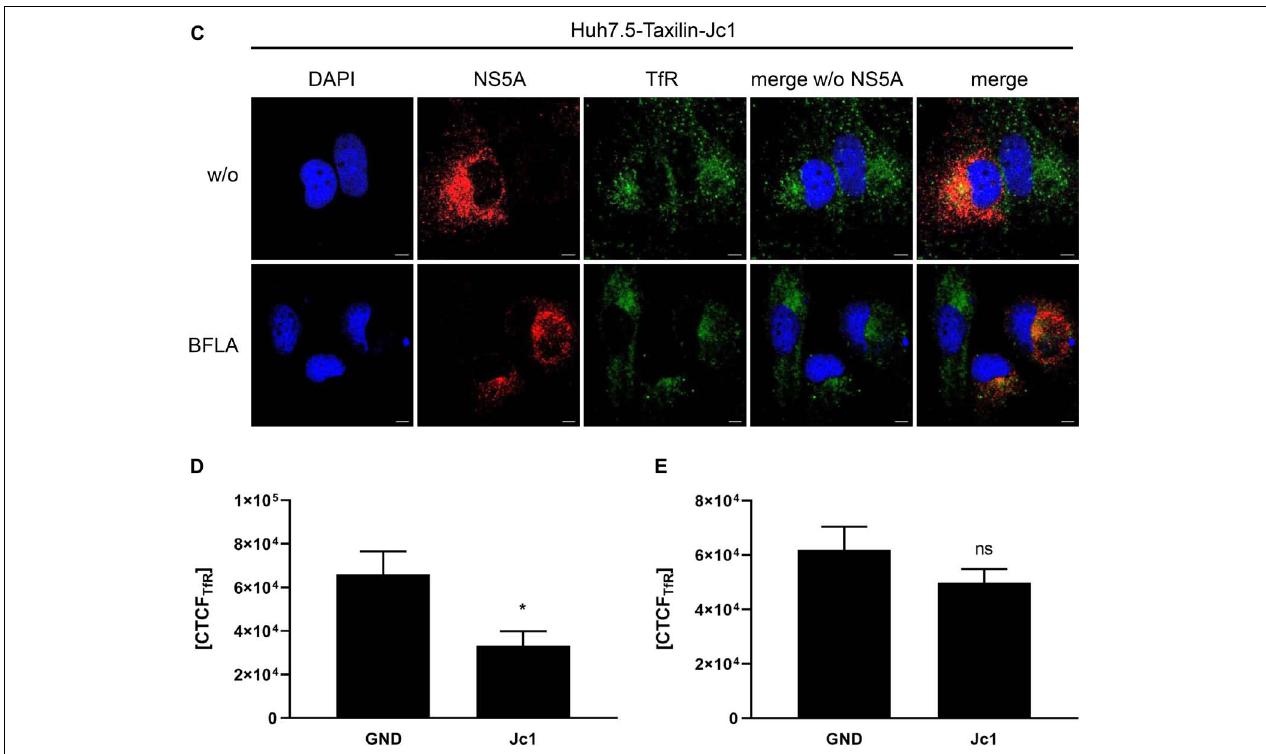
FIGURE 3 | Bafilomycin A leads to an accumulation of TfR in HCV-replicating cells. (A) CLSM analysis of HCV-negative Huh7.5 cells (GND) treated with BFLA (50 nM) for 16 h. The cells were stained with TfR (green) and NS5A-specific (red) antibodies. Nuclei were stained with DAPI (blue). Laser intensity and digital gain were kept constant for untreated and BFLA-treated cells. Magnifications, x100. Scale bar represents 5 µ m. (B) CLSM analysis of HCV-positive Huh7.5 cells (Jc1) treated with BFLA (50 nM) for 16 h. The cells were stained with TfR (green) and NS5A-specific (red) antibodies. Nuclei were stained with DAPI (blue). Laser intensity and digital gain were kept constant for untreated and BFLA-treated cells. Magnifications, x100. Scale bar represents 5 µ m. (C) CLSM analysis of HCV-positive Huh7.5-Taxilin cells (Jc1) treated with BFLA (50 nM) for 16 h. The cells were stained with TfR (green) and NS5A-specific (red) antibodies. Nuclei were stained with DAPI (blue). Laser intensity and digital gain were kept constant for untreated and BFLA-treated cells. Magnifications, x100. Scale bar represents 5 µ m. (D) Quantification of the fluorescence intensity of TfR in HCV-positive (Jc1) and HCV-negative (GND) Huh7.5 cells. Total fluorescence per cell was calculated using ImageJ software and the following formula: corrected total cell fluorescence (CTCF) = integrated density - (area of selected cell × mean fluorescence of background readings). In total, a minimum of 10 cells were measured (mean ± SEM). Two-tailed unpaired t -test, * p < 0.05. (E) Quantification of the fluorescence intensity of TfR in HCV-positive (Jc1) and HCV-negative (GND) Huh7.5-Taxilin cells. Total fluorescence per cell was calculated using ImageJ software and the following formula: corrected total cell fluorescence (CTCF) = integrated density - (area of selected cell × mean fluorescence of background readings). In total, a minimum of 10 cells were measured (mean ± SEM). Two-tailed unpaired t -test, ns = not